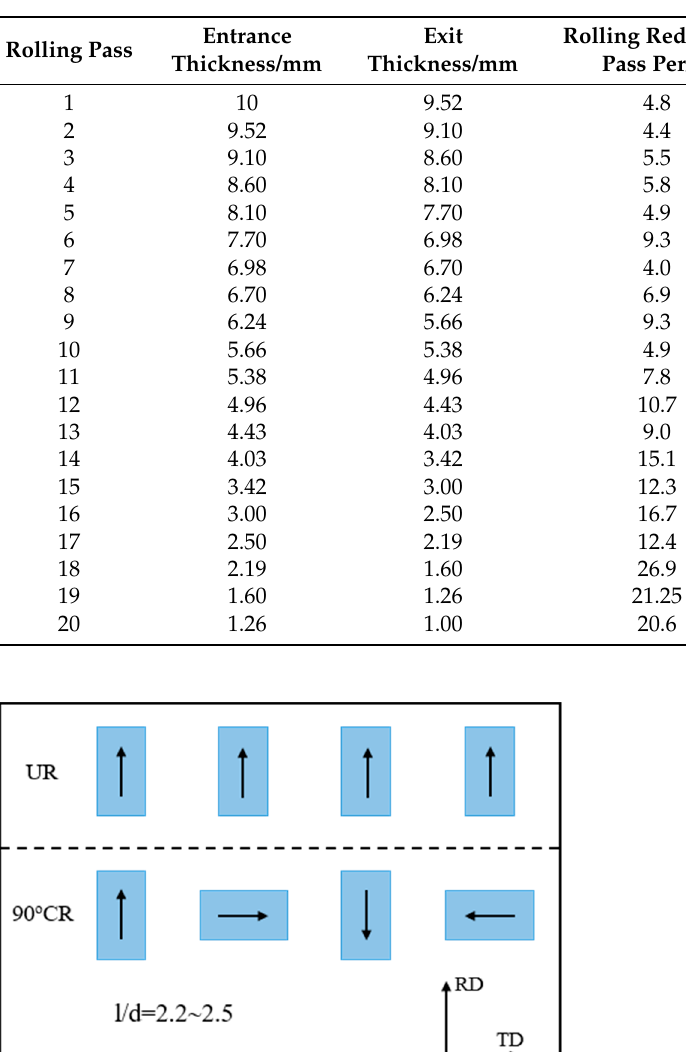
Table 2. The rolling parameter for unidirectional and 90° cross rolling.